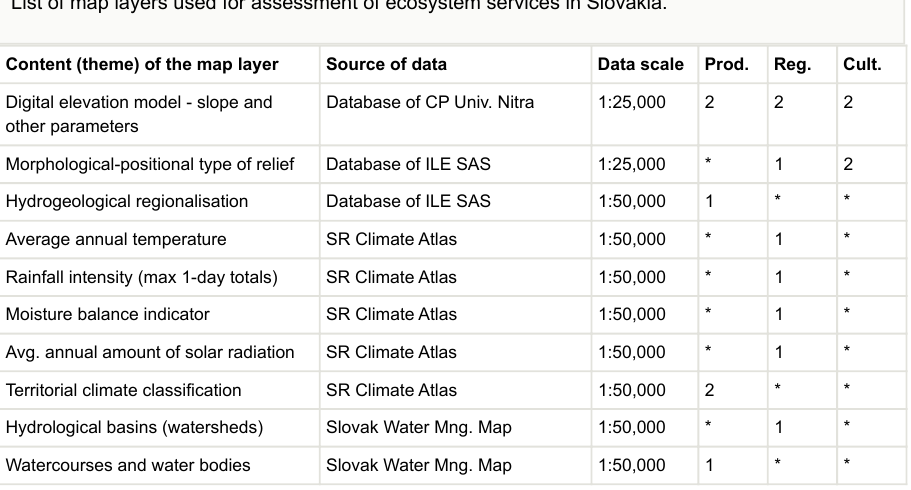
Table 2. List of map layers used for assessment of ecosystem services in